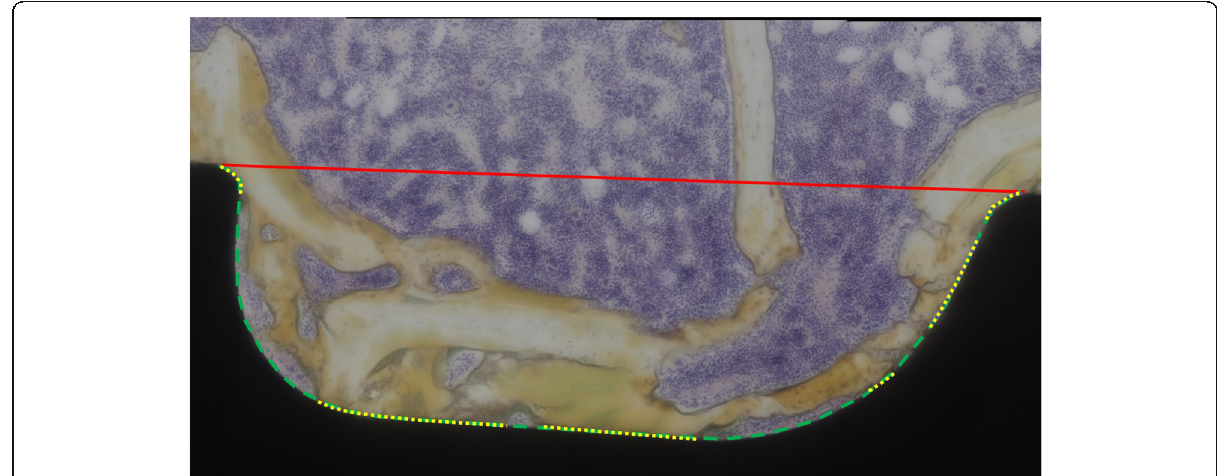
Fig. 3 Bone formation index. The ratio of the length of the part where the bone is in direct contact (yellow line) with the length of the inserted screw (green line) was termed bone formation